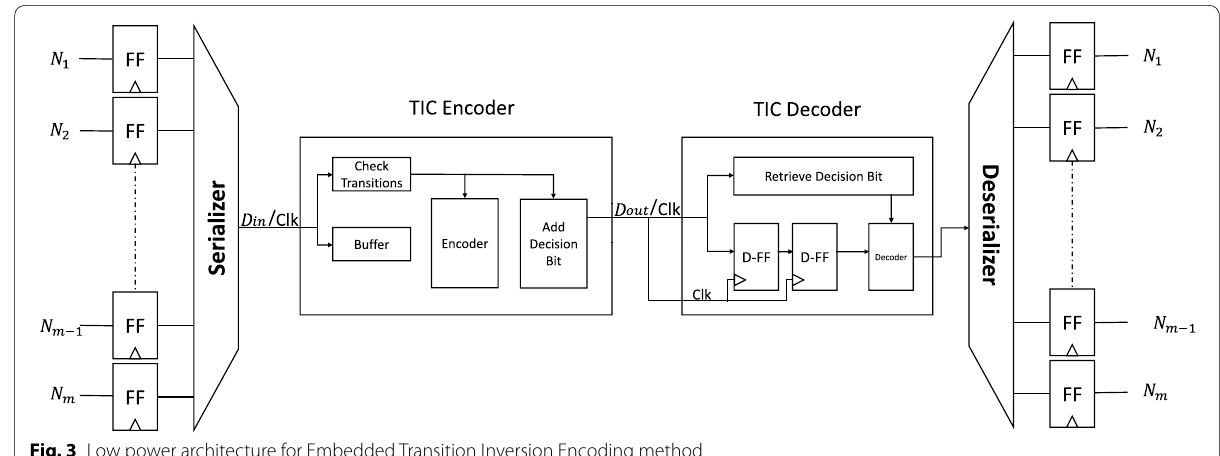
Fig. 3 Low power architecture for Embedded Transition Inversion Encoding method